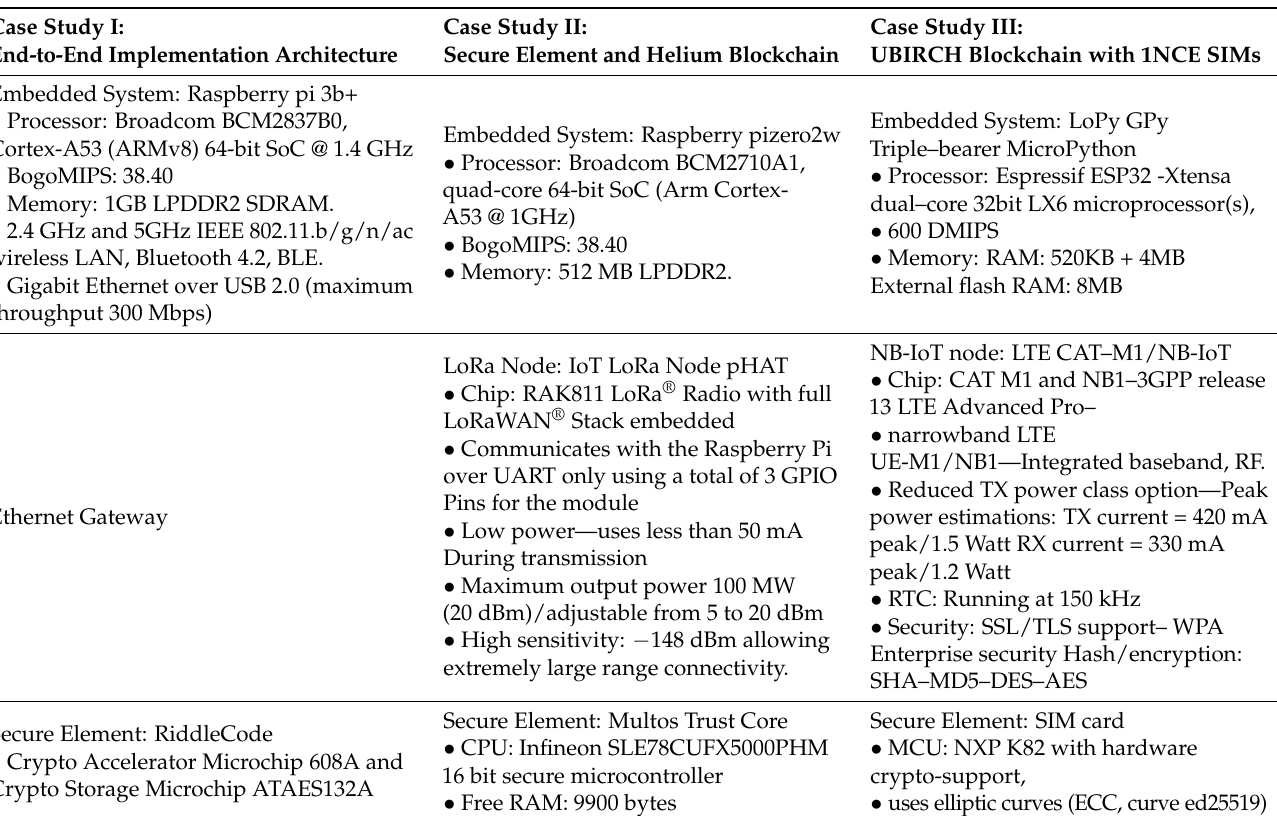
Table 6. The overheads of all three setups unveil the computing efficiency and technical characteristics and IoT communication